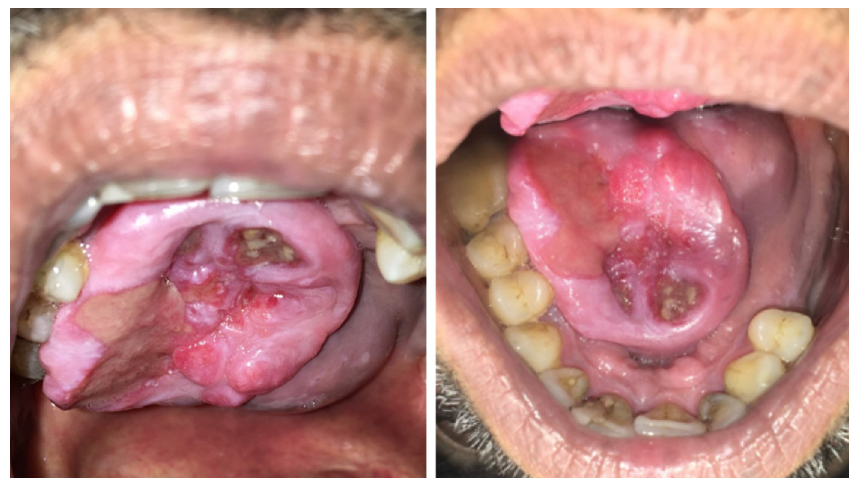
Fig. 1. Photograph showing the fl eshy mass in the palatal mucosa on the left side and mirror image of the palatal mass on the right side. Table I. Table depicting lesions that can present as palatal masses with differentiating features [2 – 9]. Lesions Differentiating features Histopathological